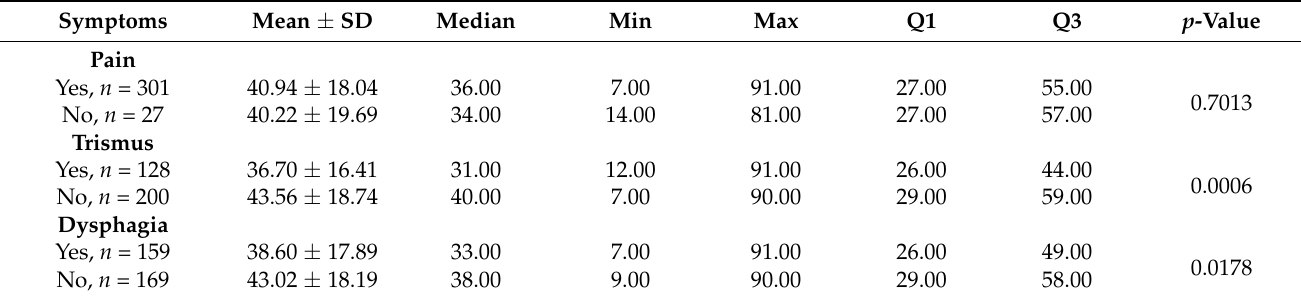
Figure 1. ( a – d ) Correlation of WBC, CRP, duration of hospitalization, number of accompanying diseases, and the patient age. The strength of the correlations was determined using Spearman’s rank correlation coefficient; p < 0.05 was considered statistically significant. Table 5. Comparison of selected symptoms of infection and age between patients presenting these symptoms and not presenting these